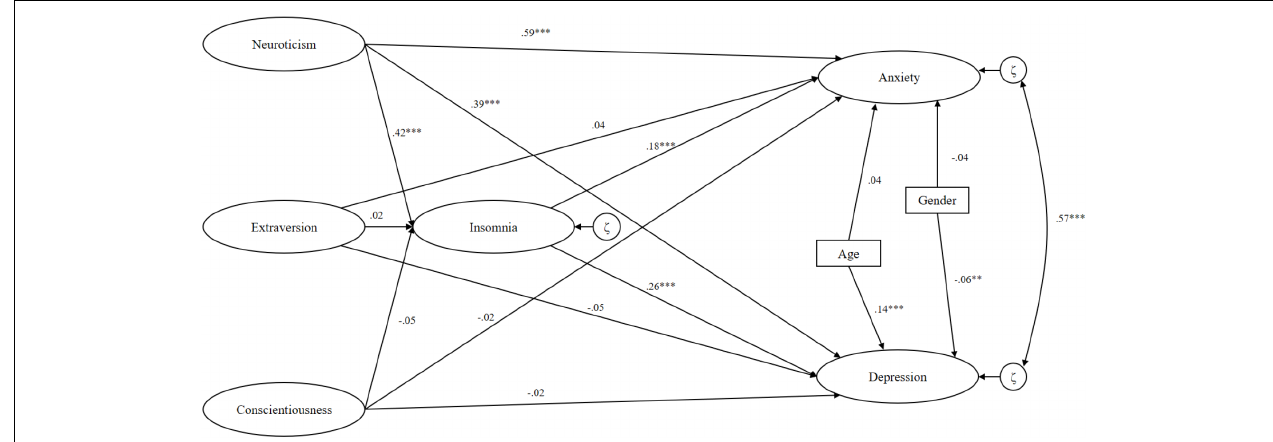
FIGURE 2 | Latent paths between variables in the structural